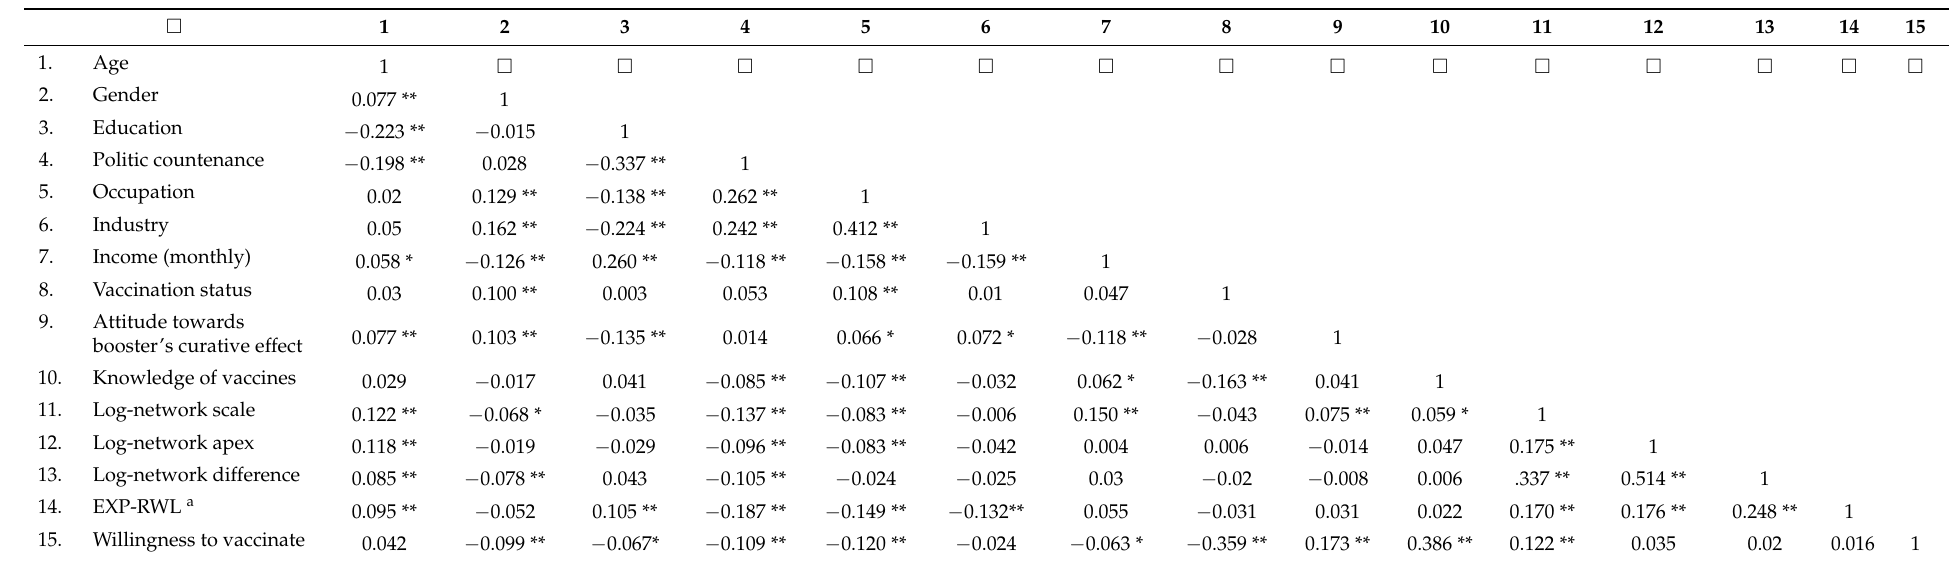
Table 3. Correlation analysis of acceptance of vaccine booster